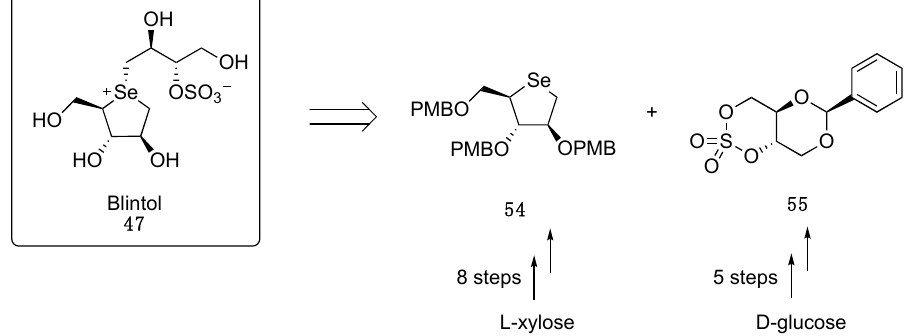
Scheme 8. Retrosynthetic analysis of blintol ( 47 ).